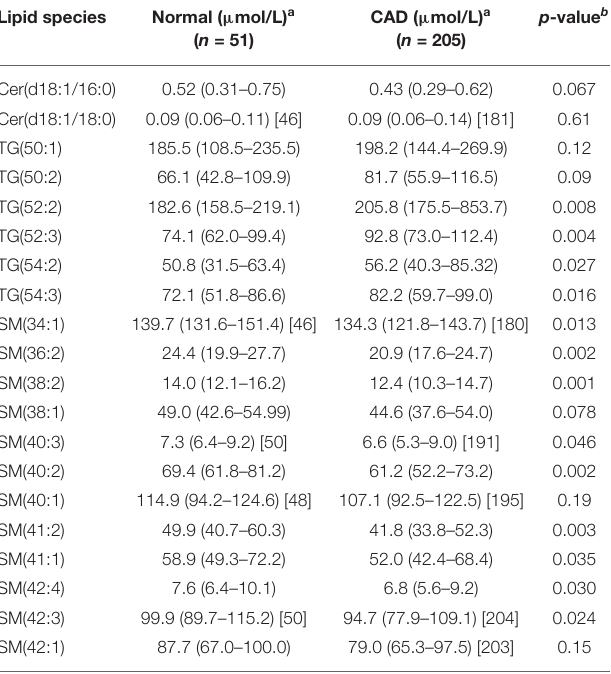
TABLE 2 | Considered ceramides, triglycerides, and sphingomyelins. Lipid species